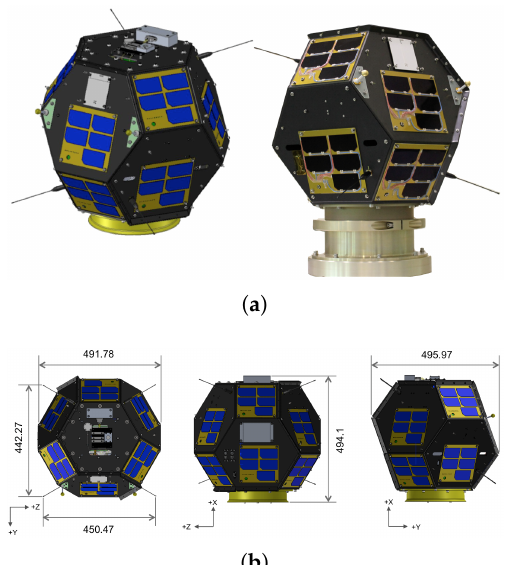
Figure 1. Ten-Koh satellite flight model configuration once in orbit. The black external structure is made of CFRP. ( a ) Computer-aided design rendering on the left, flight model photograph on the right. ( b ) The envelope allowed by the launch vehicle was 500 mm × 500 mm × 500